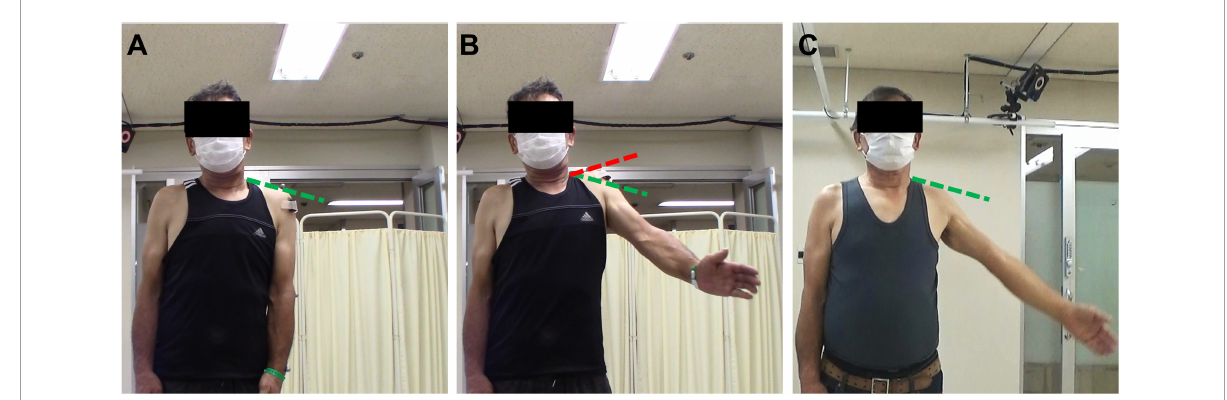
FIGURE10 Characteristic shrugging motion observed in patients to compensate for weakness of the deltoid. The green hatched line marks the acromion elevation during a relaxed state of the scapula (A) and is the same for the three pictures. The red hatched line marks the acromion elevation during the excessive shrugging compensatory motion. (A) Rest state. (B) Compensatory motion (first session, patient 4). (C) No compensatory motion (last session, patient 4).